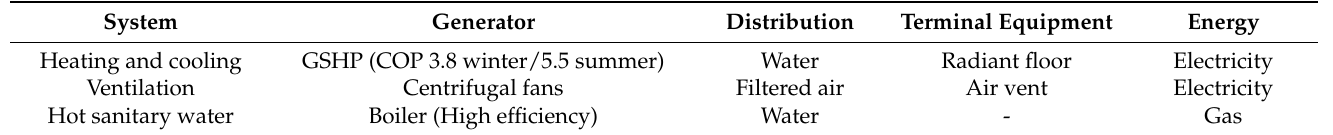
Table 4. Building’s thermal system configuration detailed in the BIM